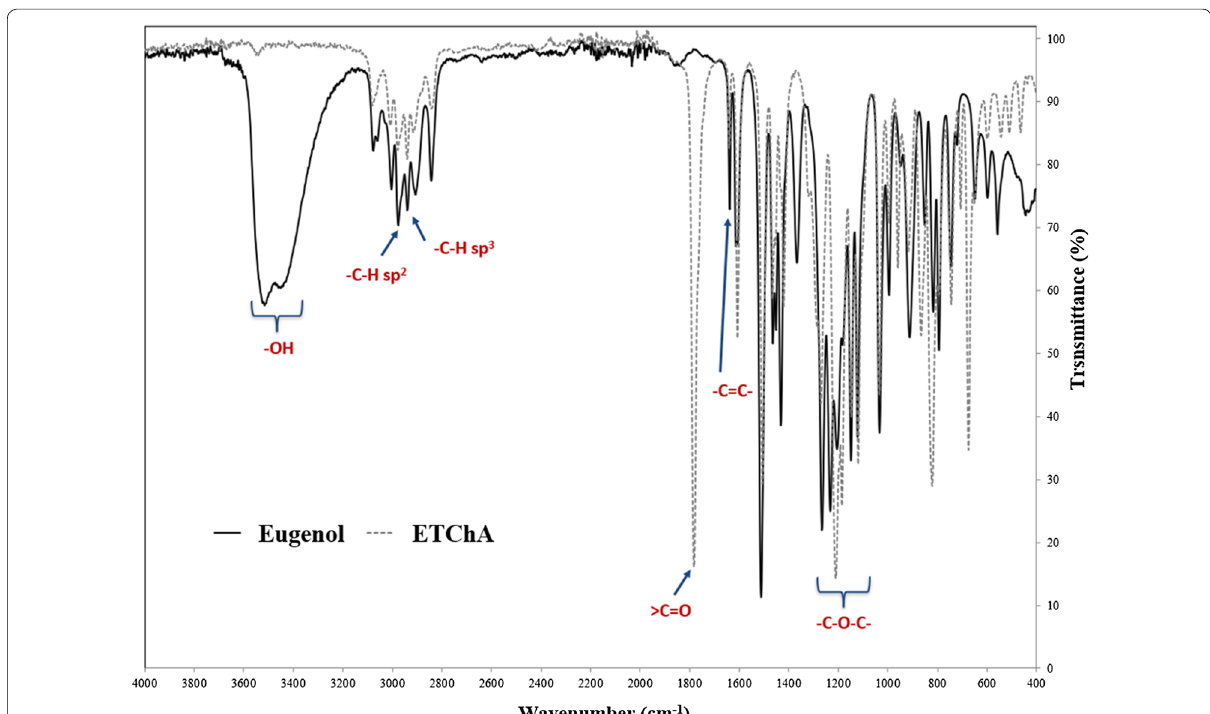
Fig. 4 Example of the IR spectrum of eugenol and ETChA